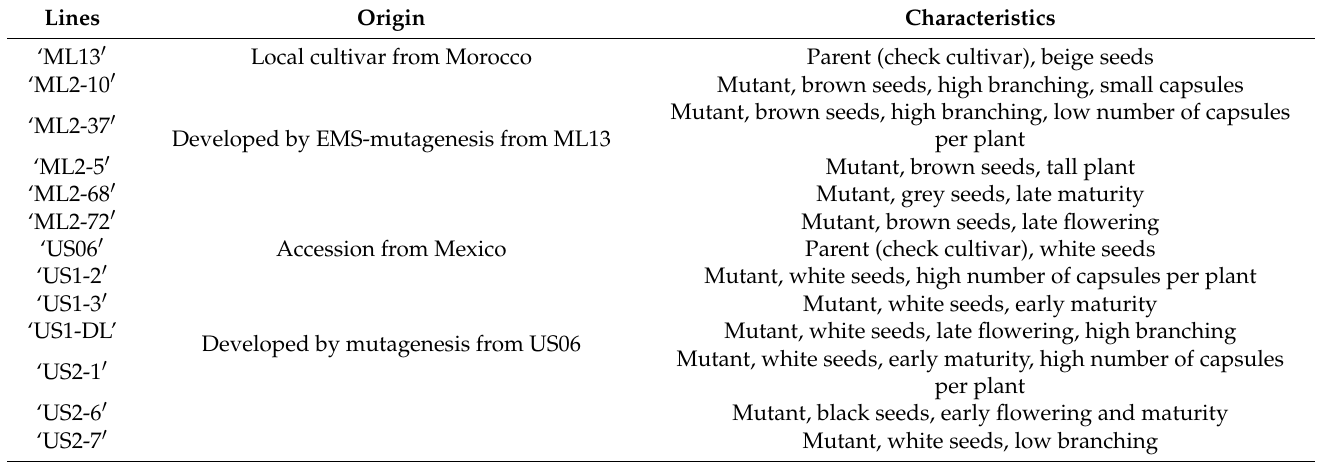
Table 1. Main phenotypic characteristics of the 13 sesame genotypes studied.